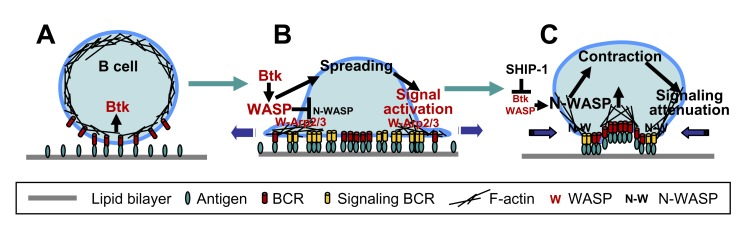
A working model for the coordination of N-WASP with WASP in the regulation of BCR signaling.(A) Antigen binding to the BCR induces an early activation of Btk. (B) Activated Btk in turn activates and translocates WASP to the cell surface. Activated WASP (W) stimulates actin polymerization and reorganization by binding to Arp2/3 and suppresses N-WASP activation, which drives B-cell spreading and facilitates BCR clustering and signaling. (C) The activation of SHIP-1 induced by the BCR after initial signaling inhibits Btk and WASP activation, consequently releasing N-WASP from WASP suppression. Active N-WASP decreases actin accumulation at the B-cell contact zone, which enables B-cell contraction and promotes the coalescence of BCR microclusters into a central cluster and BCR internalization. The formation of BCR central clusters and BCR endocytosis lead to the down-regulation of BCR signaling at the cell surface.